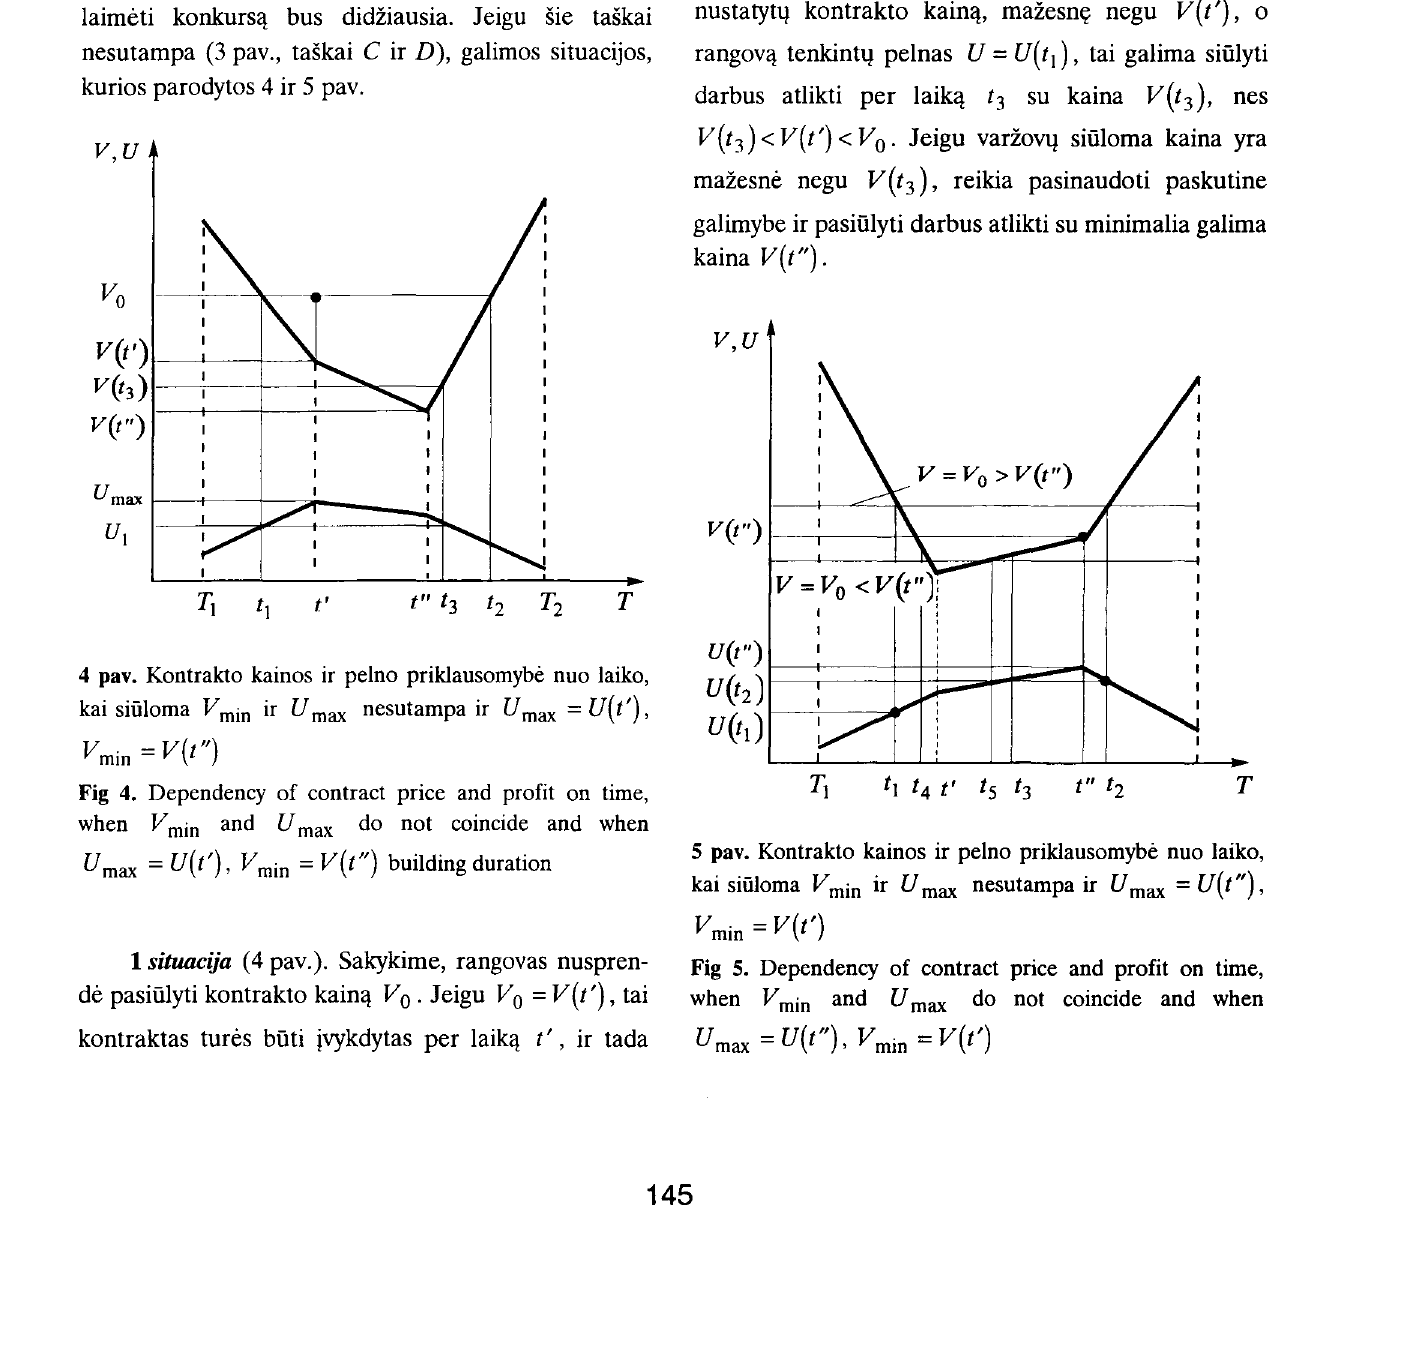
pelno U netinka, nes siuo atveju reiketq siiilyti 2 ,